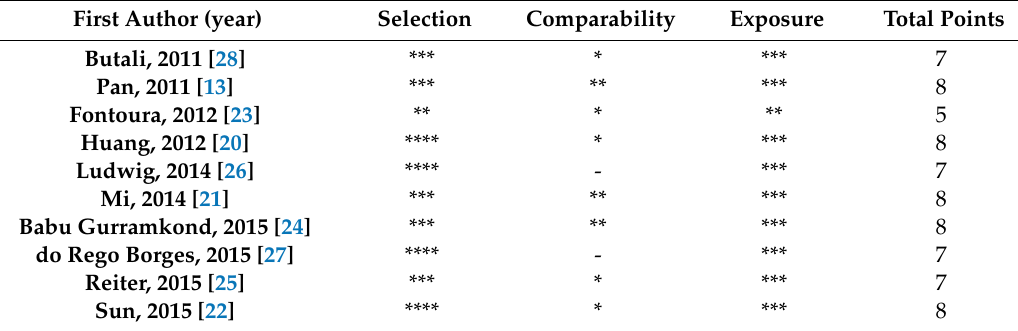
Table 3. Quality assessment scores for the studies included in this meta-analysis.